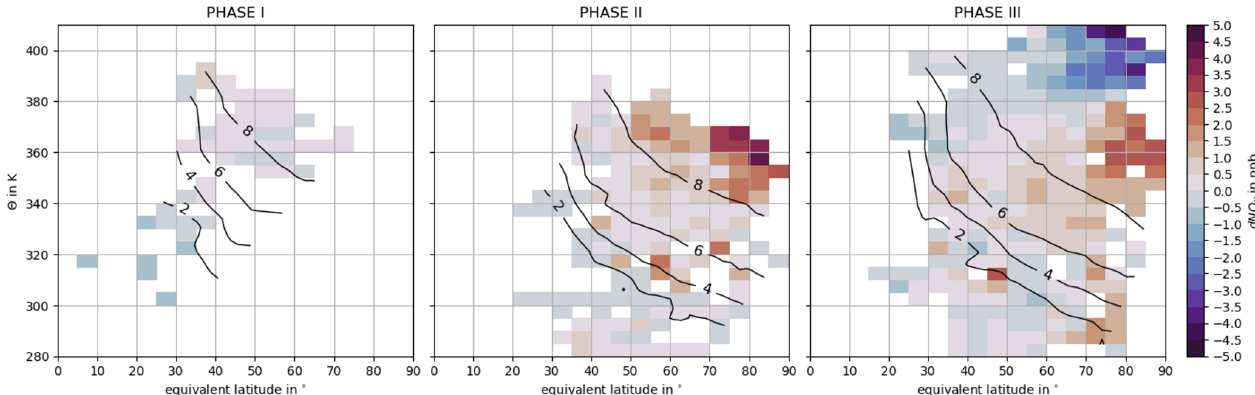
Figure 9. Distribution of dNO y in coordinates of equivalent latitude and potential temperature (theta) during phase I (13 December–21 De- cember), phase II (12 January–2 February), and phase III (26 February–18 March). The black contours show potential vorticity in